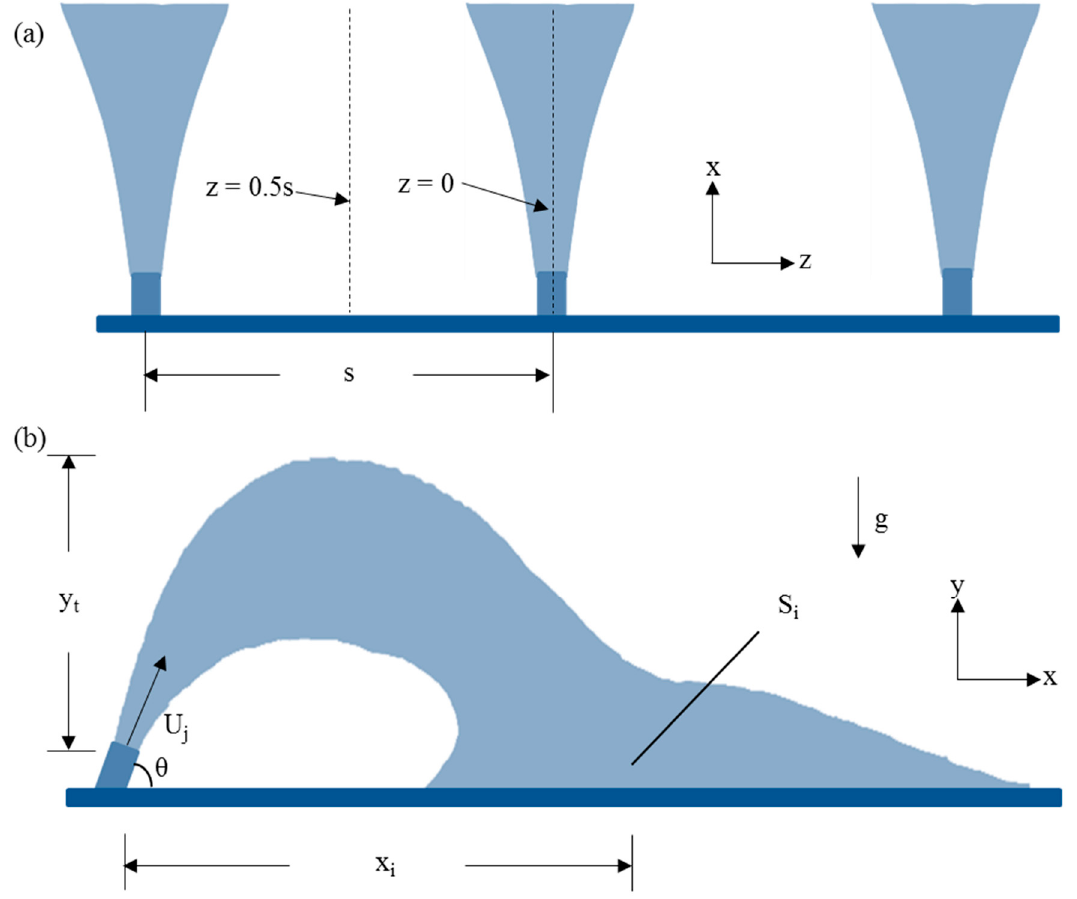
Figure 1. Schematic of multiple inclined dense jets: ( a ) plan view; ( b ) elevation view